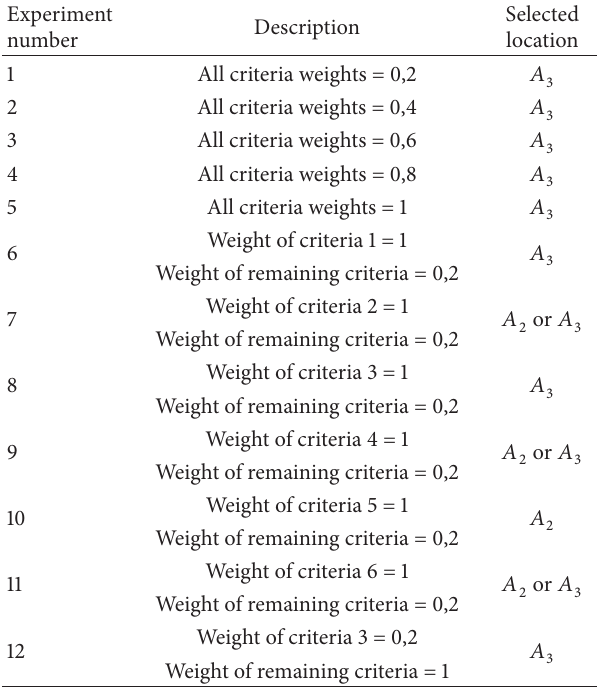
Table 15: Experiments for sensitivity